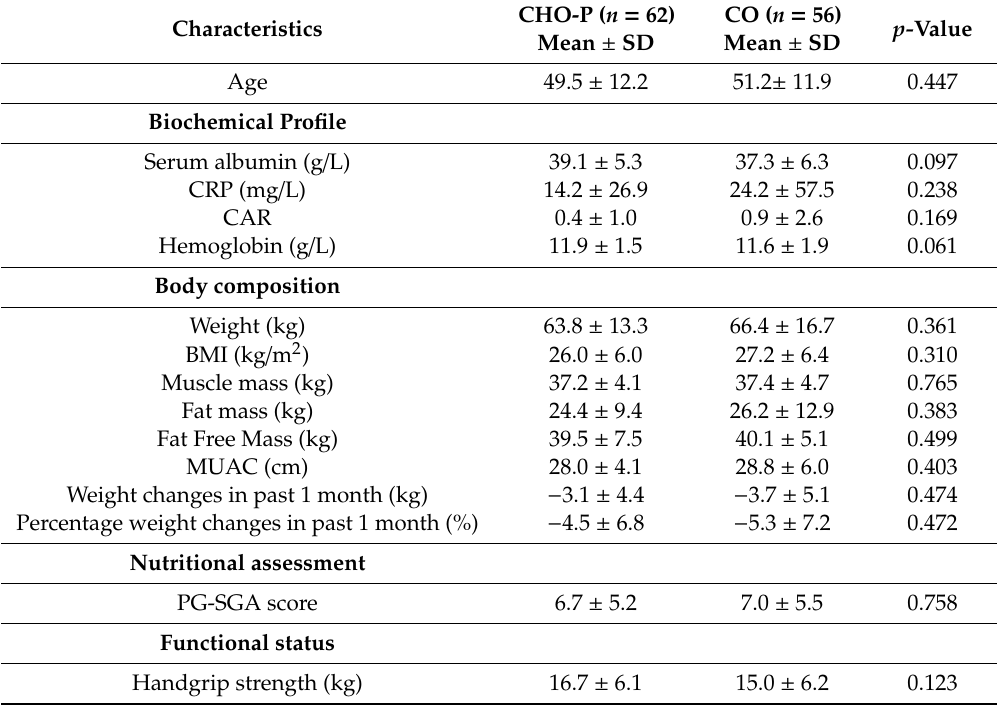
Table 4. Baseline clinical characteristics of intervention group (CHO-P) and control group (CO).